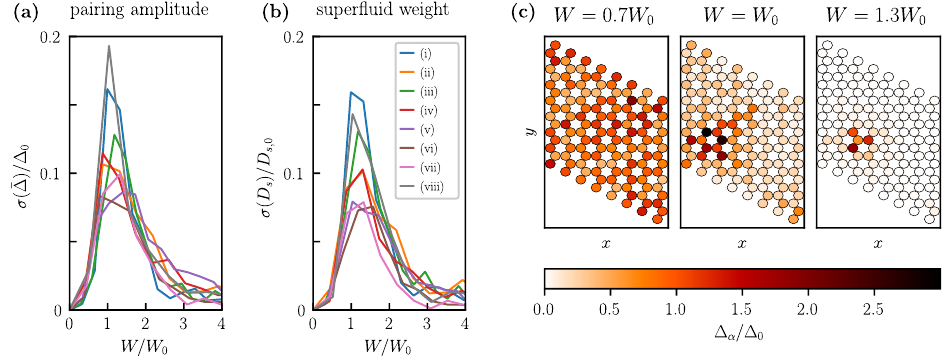
Figure 8: Ensemble standard deviations σ of (a) the pairing amplitude ¯ ∆ (spatial average) and (b) the superfluid weight D as a function of W / W for the models s 0 considered in Fig. 1 of the main text: (i)-(v) topological and trivial extended Kane- Mele models, (vi)-(viii) trivial single-band models. (c) Spatial profile ∆ α of the pair- ing amplitude for single disorder realizations of the flat Kane-Mele model [ model (i) ] at different disorder strengths W / W . White corresponds to a vanishing pairing 0 amplitude, whereas darker colors signify a larger values. Around W = W , the su- 0 perconductor breaks up into isolated superconducting islands accompanied by large fluctuations of ¯ ∆ and D s